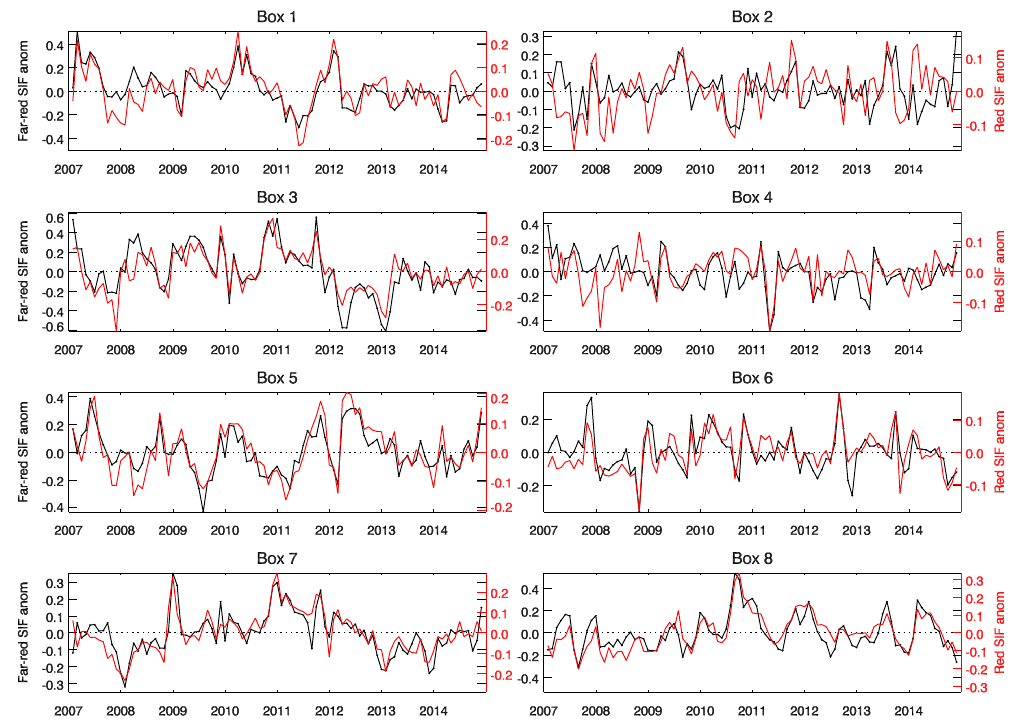
− 2 nm − 1 sr − 1 ) from GOME-2